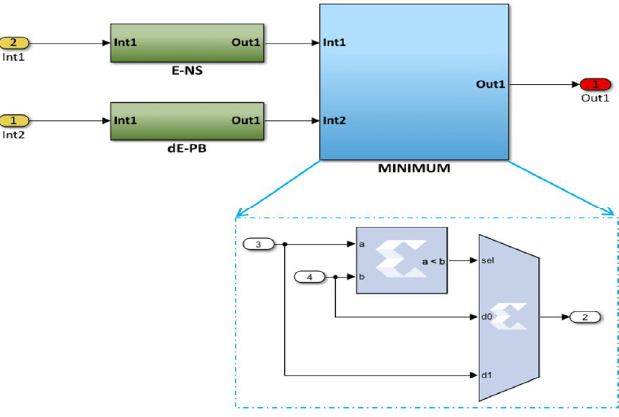
(22) Figure 20. Design of ZE membership function from XSG. 4.1.4. Design of Rules Sugeno developed such a fuzzy logic controller, which was a MIN function, used to fi nd the minimal value in our research work between the membership functions of the two inputs, which are the error and its derivative. This controller re fl ects the AND opera- tor that links between various fuzzy functions. A rule example is provided in Figure 21: